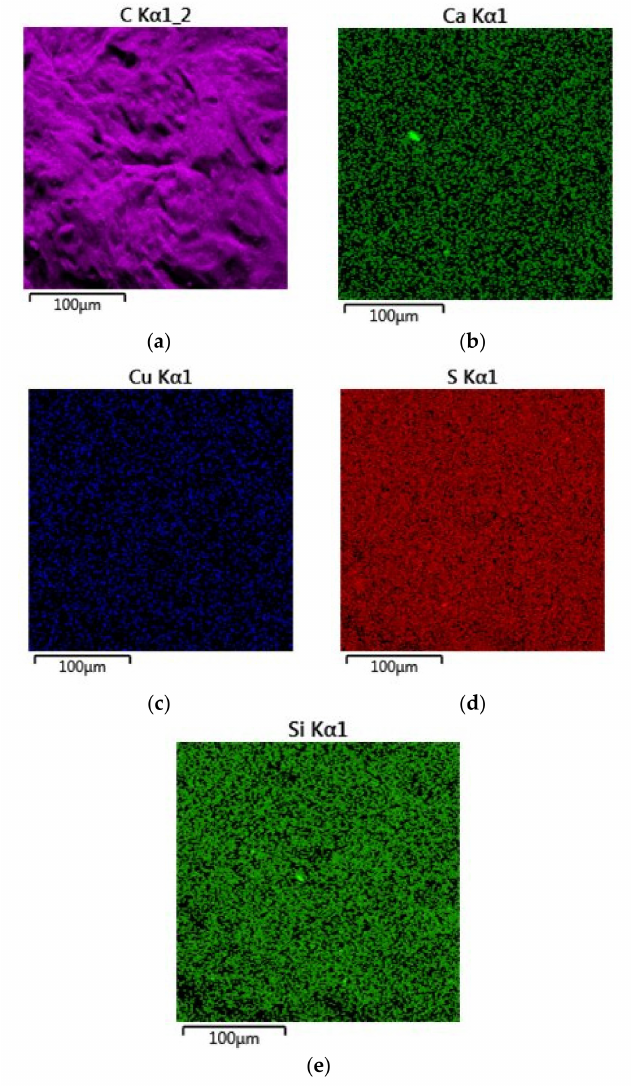
Figure 11. Distribution of individual elements identified on the microstructural surface; ( a ) carbon; ( b ) calcium; ( c ) cupper; ( d ) sulfur; ( e )